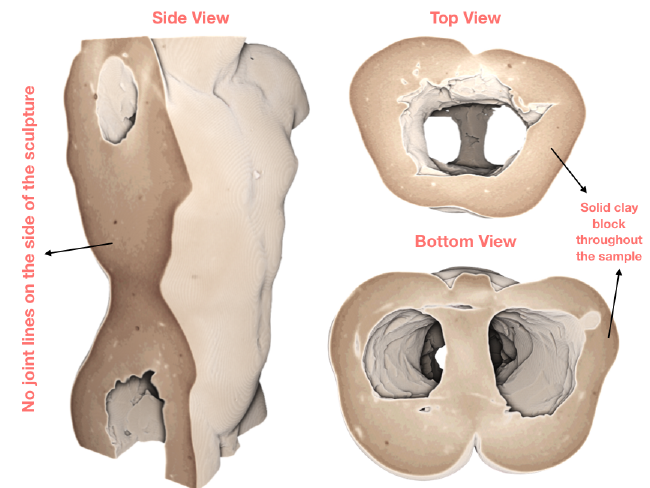
Figure 5. Despite the initial expectations, the volume renderings reveal no “joint lines” along the sides of the